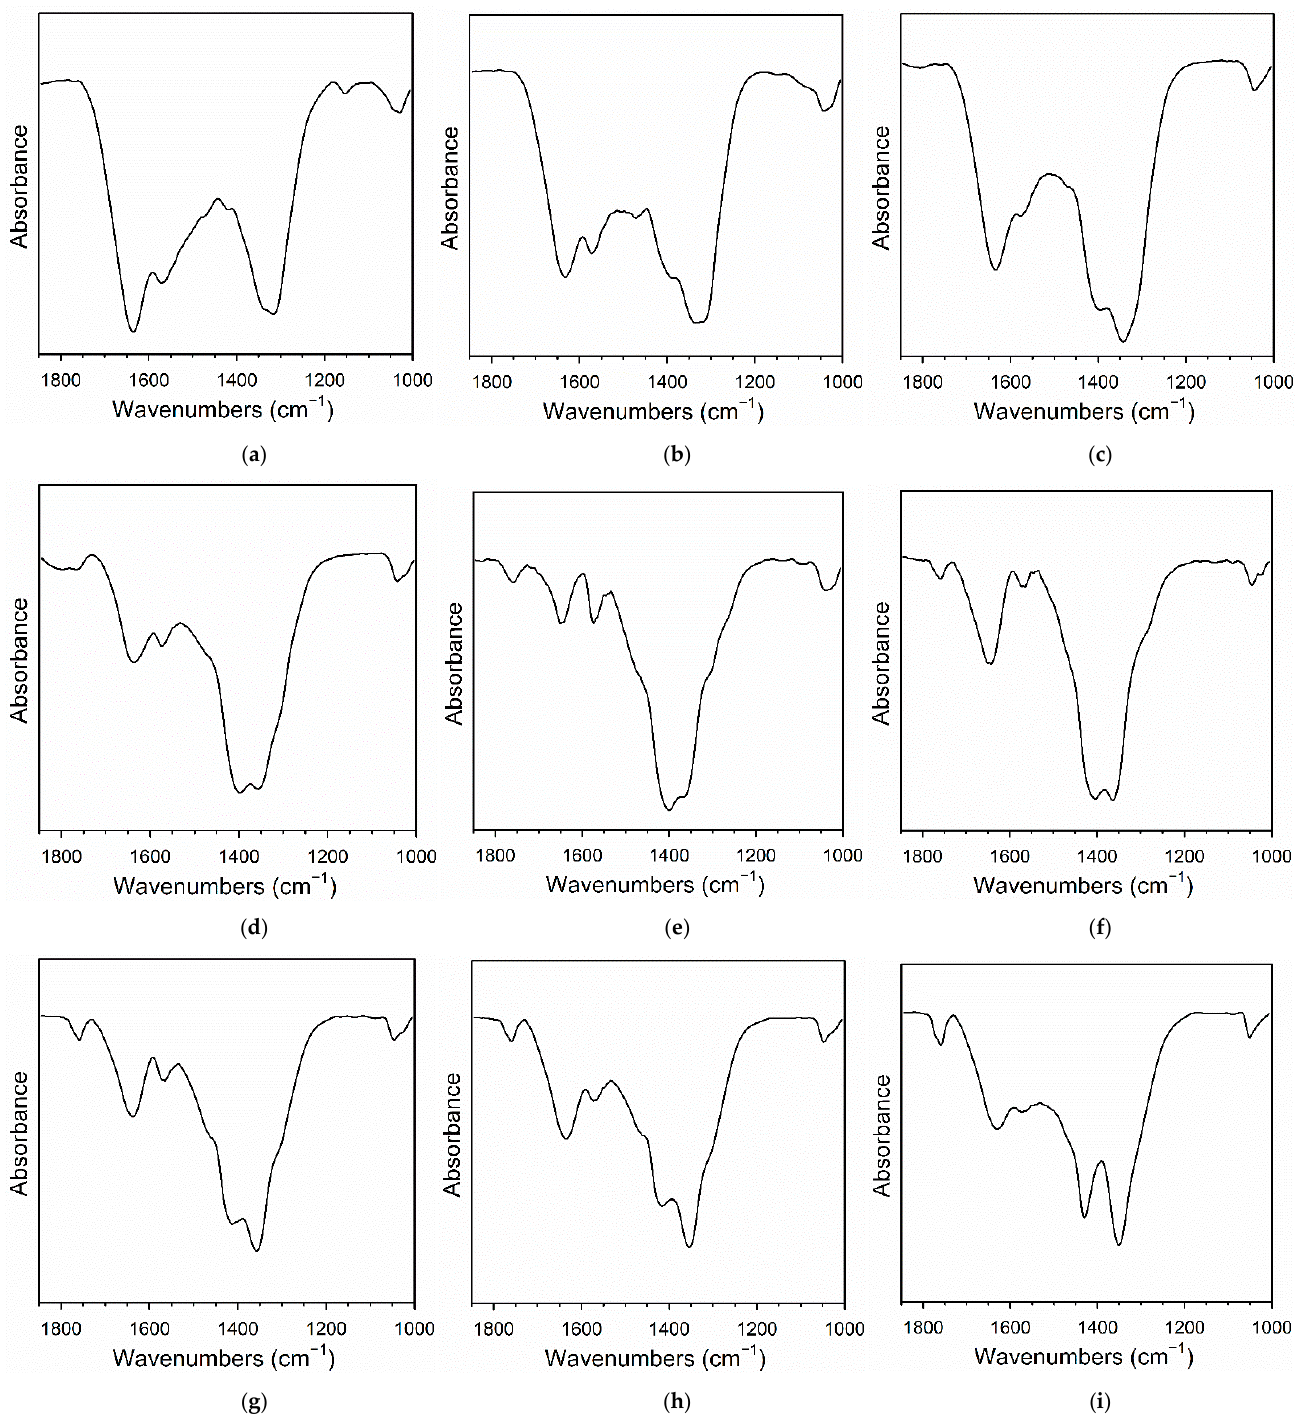
Figure 5. DRIFTS spectra of carbonate decomposition during activation for ( a ) 2%Pt/ZrO 2 , and the same doped with ( b ) 0.55%Rb, ( c ) 0.93%Rb, ( d ) 1.86%Rb, ( e ) 2.79%Rb, ( f ) 3.72%Rb, ( g ) 4.65%Rb, ( h ) 5.58%Rb, and ( i ) 9.29%Rb.